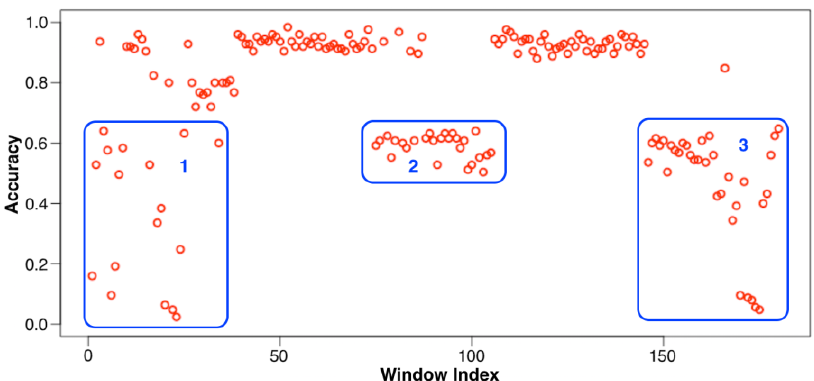
Figure 2. Correlation between accuracies of Dynamic Window (DW) with a fixed Window Width (WW = 125) and window indices.